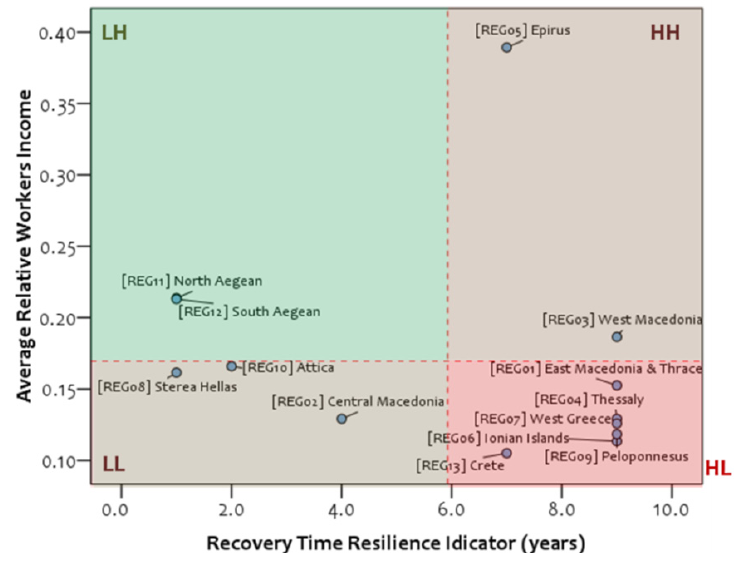
Figure 9. Correlation scatter plot, between the diachronic average Relative Workers Income (RWI) and the Recovery Time Resilience Indicator (RTSI) variable.